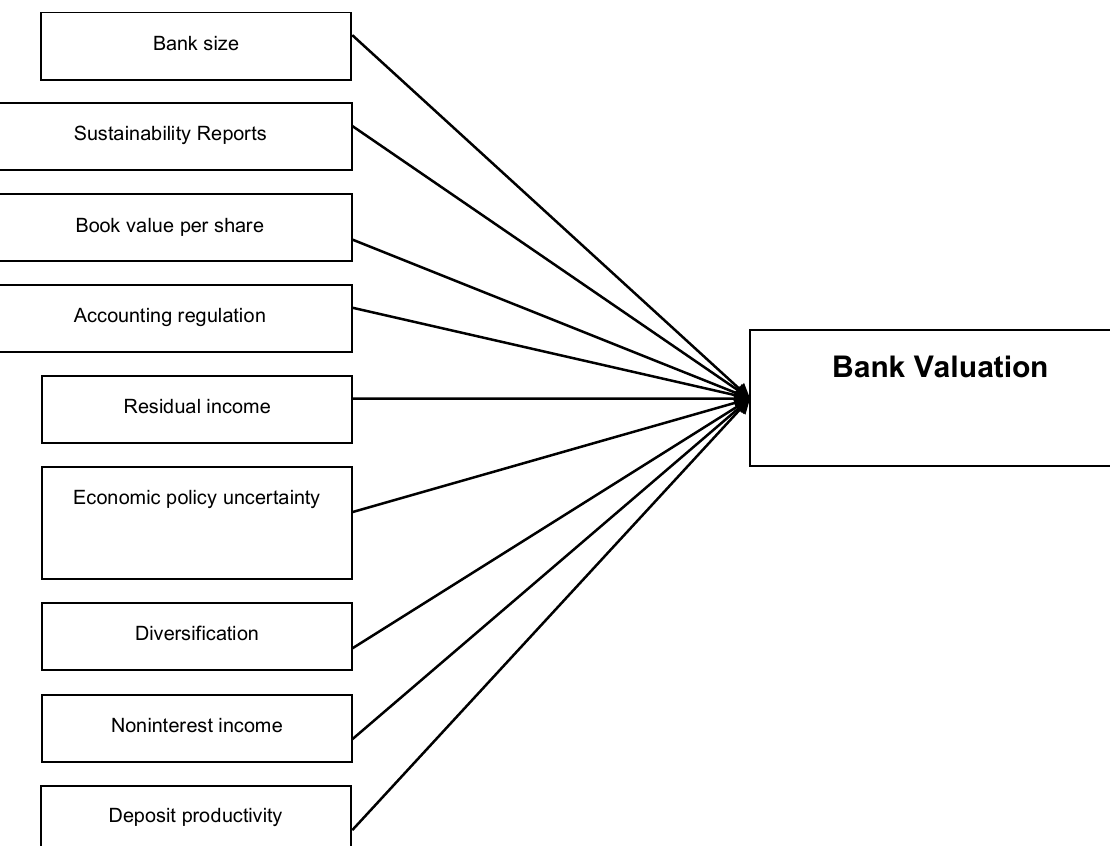
Figure 3: Value drivers of bank valuation derived from the literature review